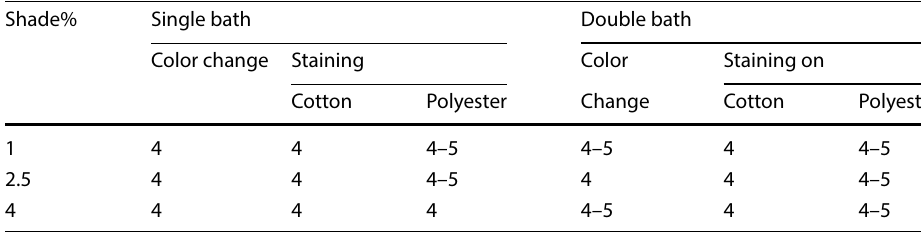
Table 6 Wash fastness properties of modified P/c blend and conventional fabric